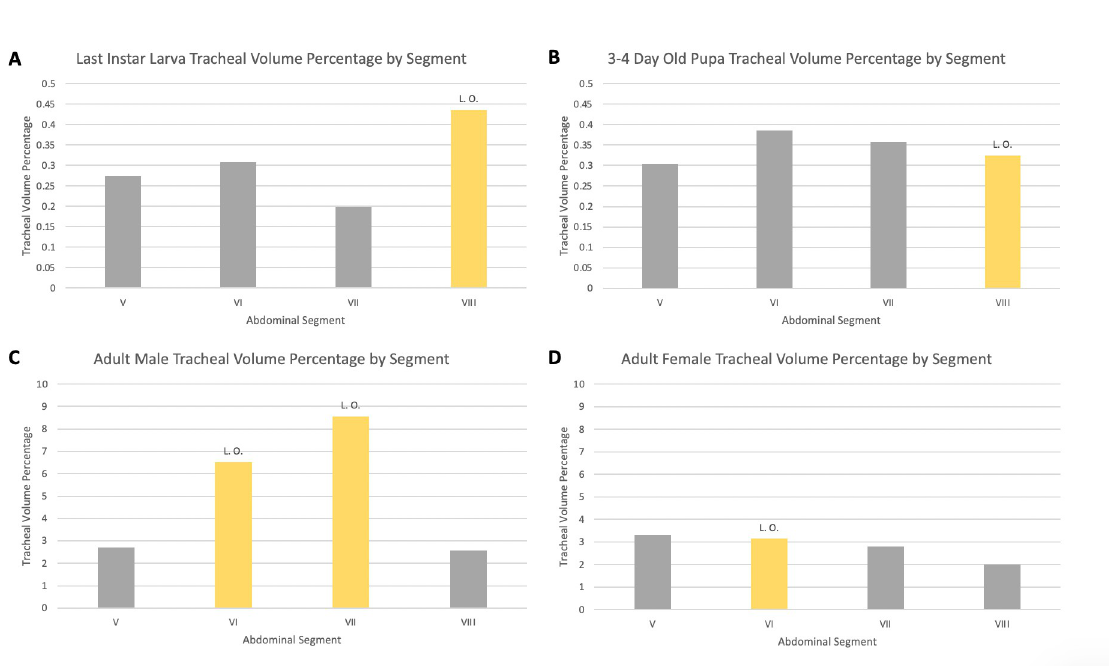
Fig 21. Tracheal volume percent by segment in larva (A), pupa (B), adult male (C), and adult female (D) Photinus pyralis . “L. O.” indicates the presence of a functional light organ on that segment.